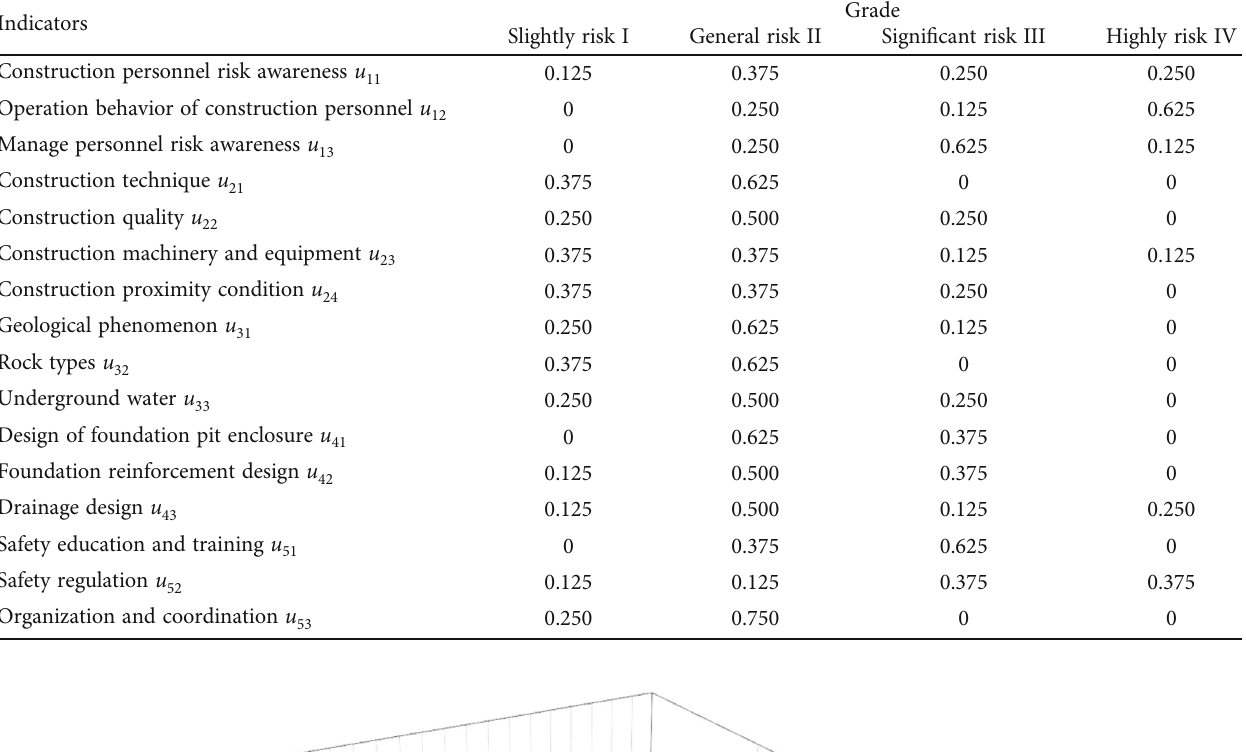
Table 11: Risk level a ffi liation.